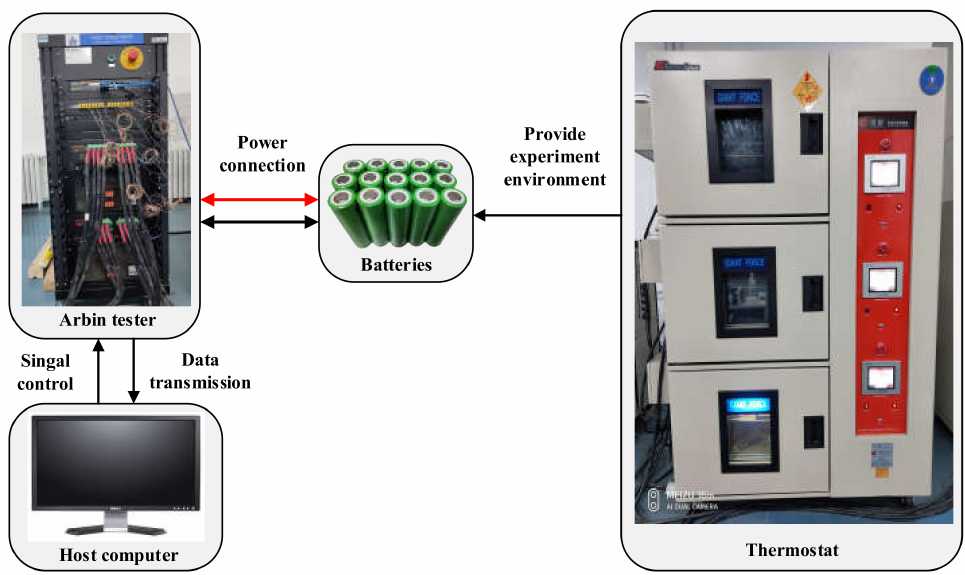
Figure 1. The experimental platform for charging and